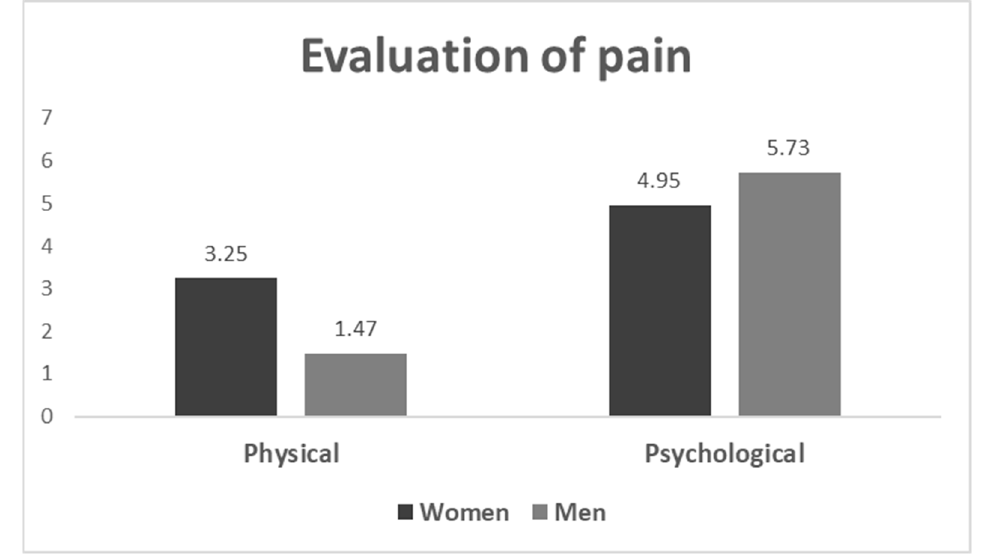
Figure 1. Evaluation of pain in patients undergoing PGT.